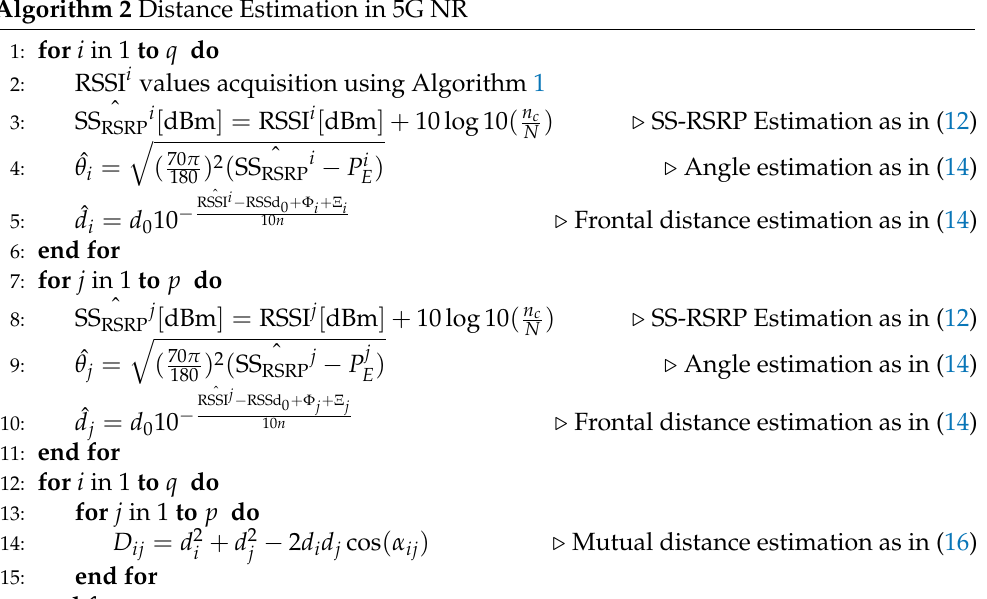
Table 1. The 5G NR Rel.15 Simulation Parameters.